Question: Produce a descriptive caption suitable for publication.
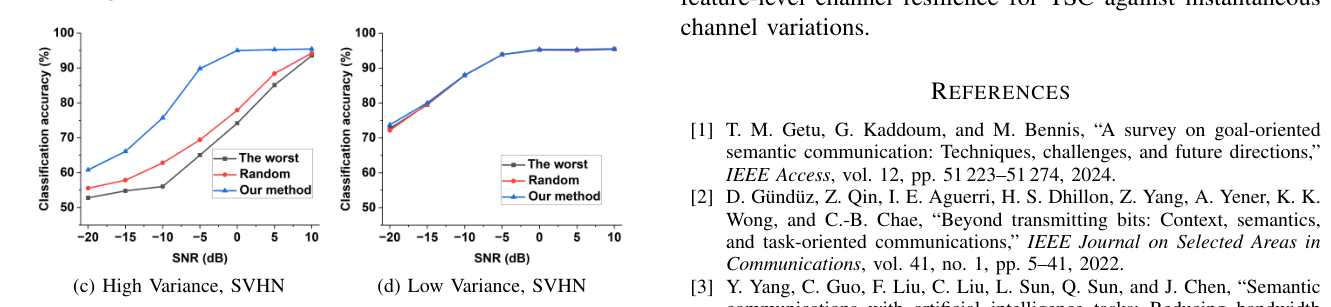
Answer: Comparison of inference performance between dynamic (high variation, 15) and stable (low variation, 2) subchannel environments on CIFAR-10 and SVHN tasks.